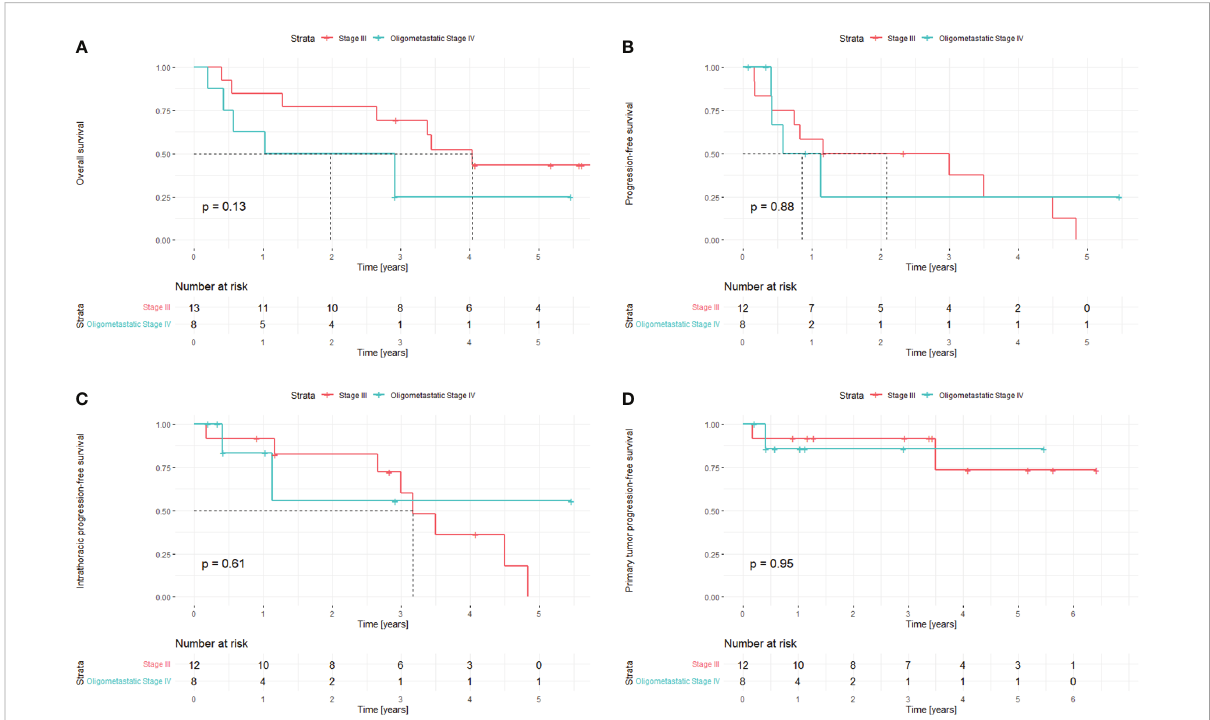
FIGURE 3 (A – D) . Oncologic outcomes strati fi ed by tumor stage following the delivery of SBRT to the primary lesion and VMAT to the draining mediastinal lymph nodes: Overall survival (A) , progression-free survival (B) , intrathoracic progression-free survival (C) and primary tumor progression-free survival (D) . In one case, radiotherapy was preliminary stopped due to pneumonia and in one case follow-up data were